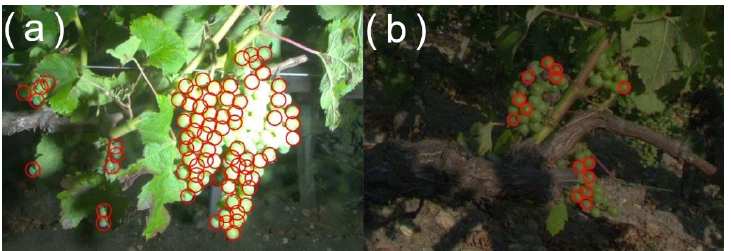
Figure 11. Example of results from the EARN dataset for the detection of berries (red circles). ( a ) Example of overexposed picture with undetected berries. ( b ) Example of a picture with no flash, showcasing undetected berries.